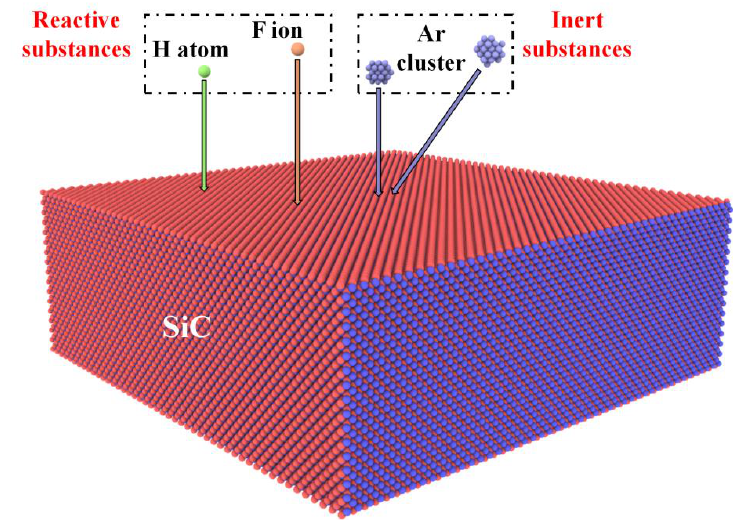
Figure 6. The typical sputtering simulation model of SiC